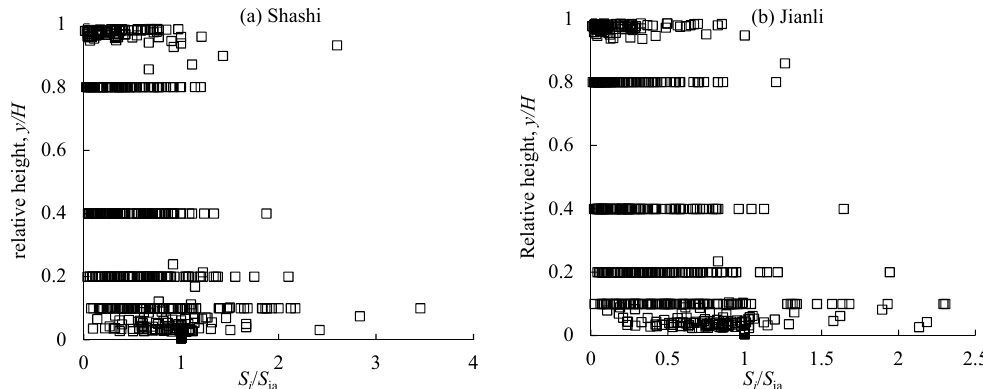
Figure 4. Vertical concentrations comparing with near-bed point concentration at Shashi ( a ) and Jianli ( b ) hydrological stations (data measured after dam operation). S i = measured concentration of the vertical profile (kg/m 3 ), and S ia = measured concentration of the near-bed point (kg/m 3 ). Table 2. Characteristics of vertical profiles of Type I and Type II measured at Shashi and Jianli hydrological stations (after dam operation).